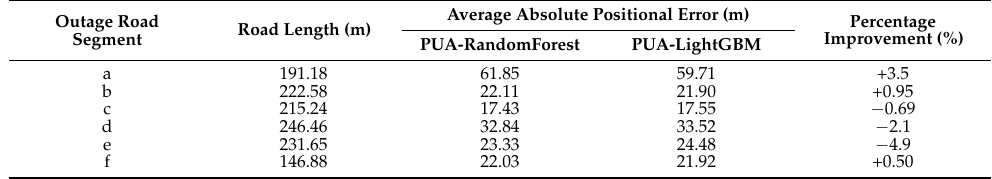
Table 3. Average absolute positional error for the PUA-LightGBM model and the PUA-RandomForest model. Outage Road